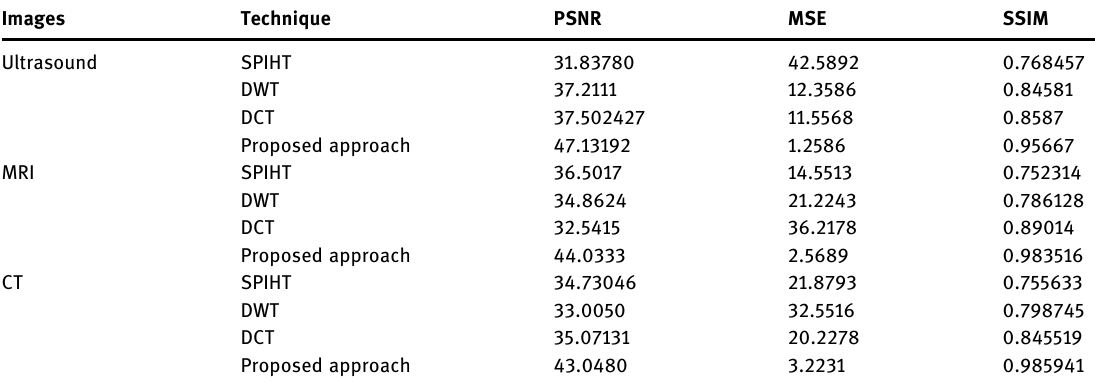
Table 8: Comparative analysis of image compression